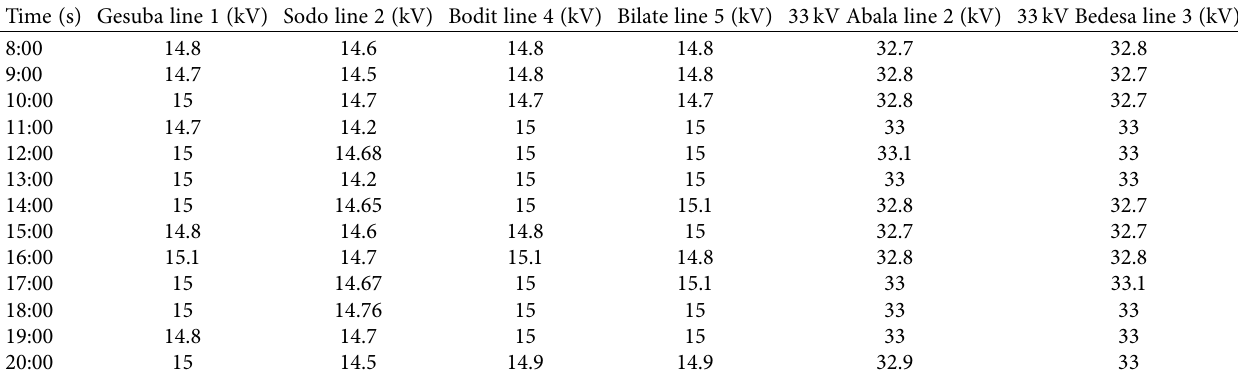
Table 1: Distribution line voltage (kV) variation for peak time 8:00–21:00.